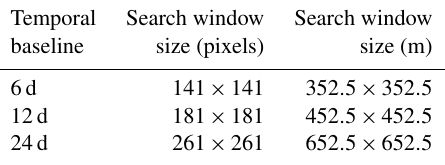
Table 2. Overview of search window sizes used to calculate offsets for the long-term flow velocity average product ( V med ). Image pairs with a temporal baseline > 24d (in rare cases of extended missing acquisitions) were not